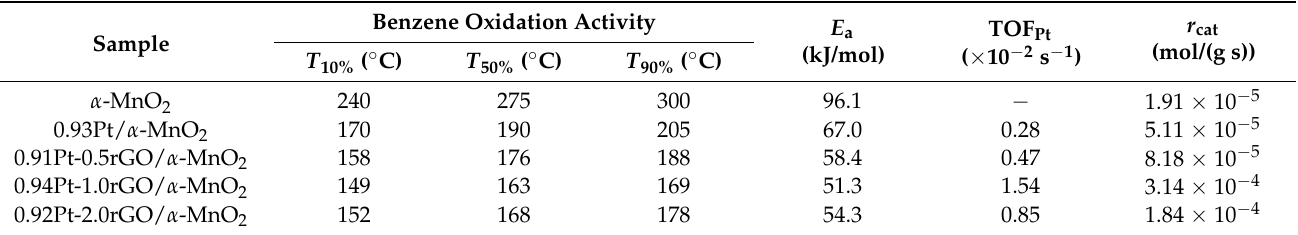
According to the activity data and the Pt loadings in the samples, their TOFs for benzene oxidation were calculated, as listed in Table 1. The TOFs (0.47 × 10 − 2 –1.54 × 10 − 2 s − 1 ) over x Pt- y rGO/ α -MnO 2 were significantly higher than that (0.28 × 10 − 2 s − 1 ) over rGO-free 0.93Pt/ α -MnO 2 . Among all of the samples, 0.94Pt-1.0rGO/ α -MnO 2 exhibited the highest TOF at 149 ◦ C (5.73 × 10 − 2 s − 1 ). Furthermore, the r cat values (8.18 × 10 − 5 –3.14 × 10 − 4 mol/(g Pt s)) over x Pt- y rGO/ α -MnO 2 were higher than that (5.11 × 10 -5 mol/(g Pt s)) over 0.93Pt/ α -MnO 2 . Among all of the samples, 0.94Pt-1.0rGO/ α -MnO 2 showed the